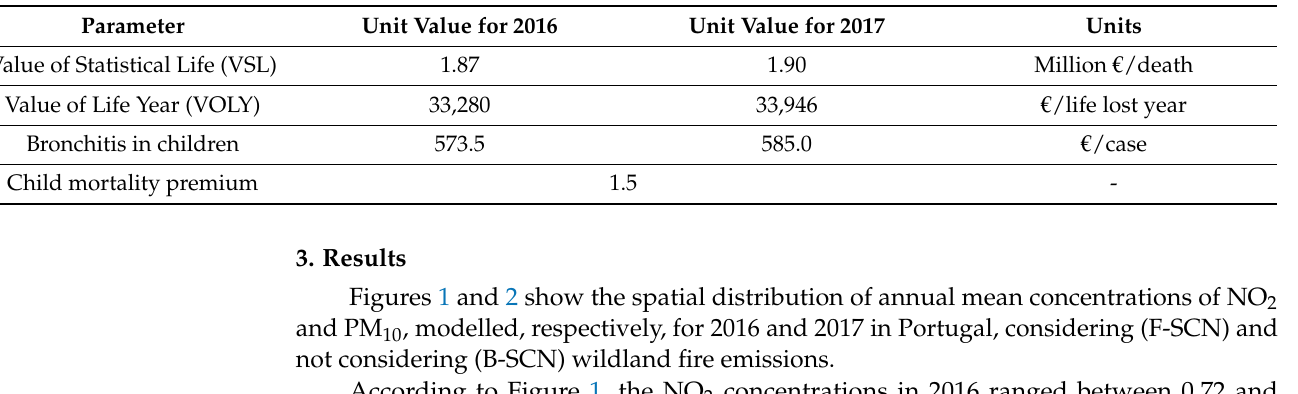
Table 3. Unit cost values for value of statistical life ( VSL ), value of a life year ( VOLY ), and bronchitis per case and child mortality premium used in this